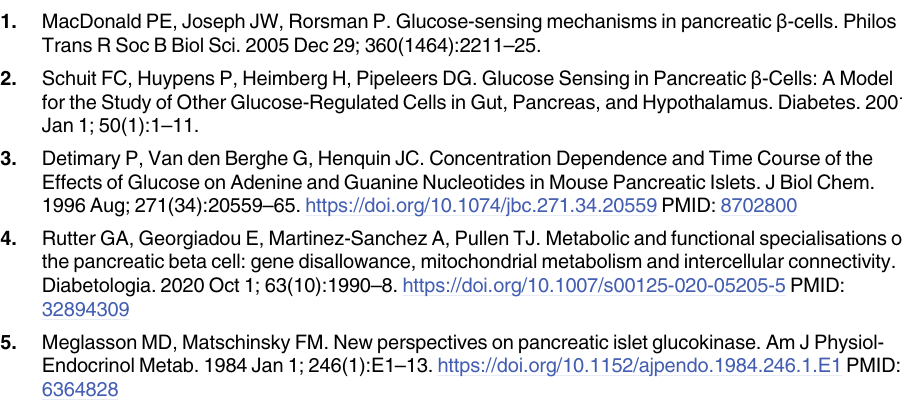
S3 Table. Multiple t -tests comparing predictions with experimental data. S4 Table. In silico metabolite fold changes following metabolic perturbations. S5 Table. Model parameter values, units, and